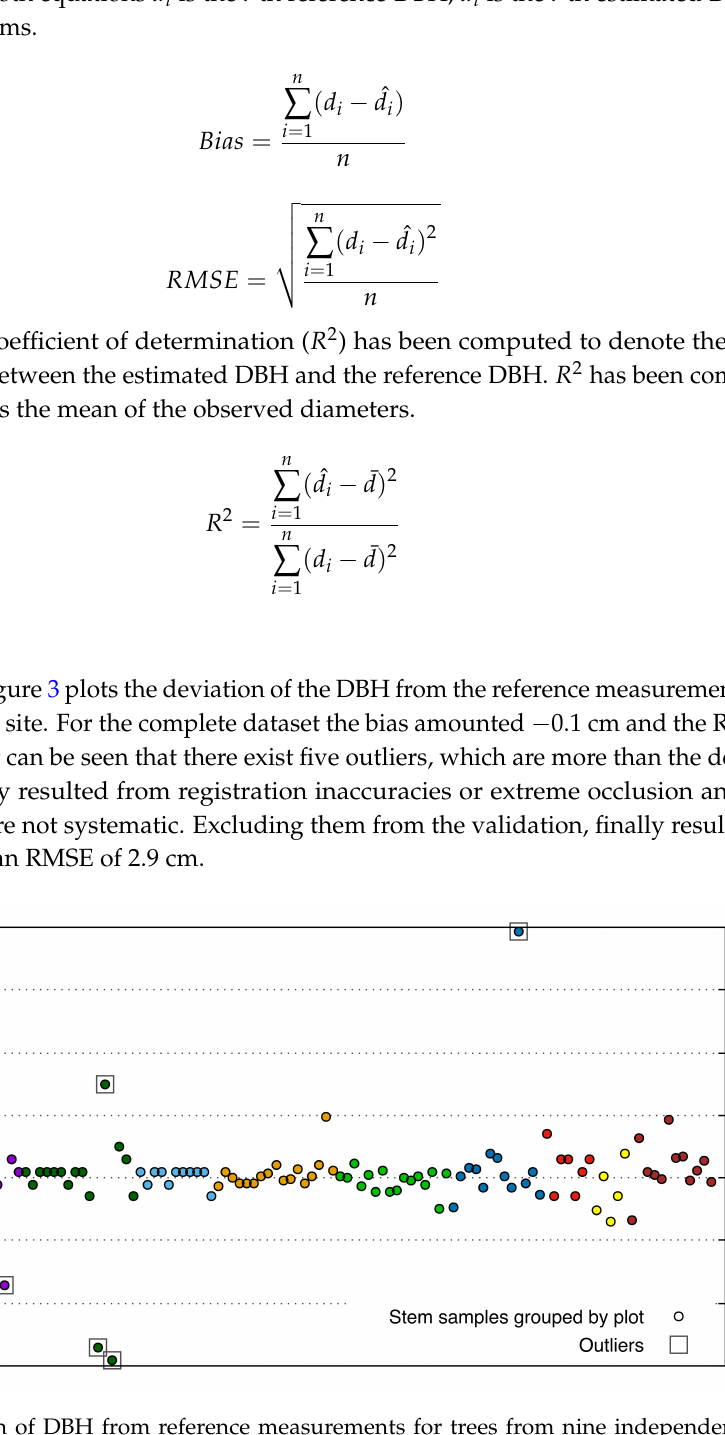
Figure 3. Deviation of DBH from reference measurements for trees from nine independent plots. The samples are grouped by plot, of which each is separated by colour. Accuracy metrics were calculated with and without the marked